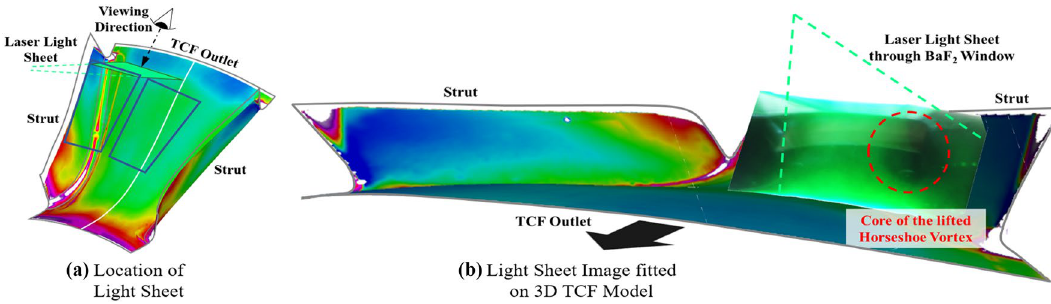
Fig. 10 Light sheet flow visualization of the horseshoe vortex